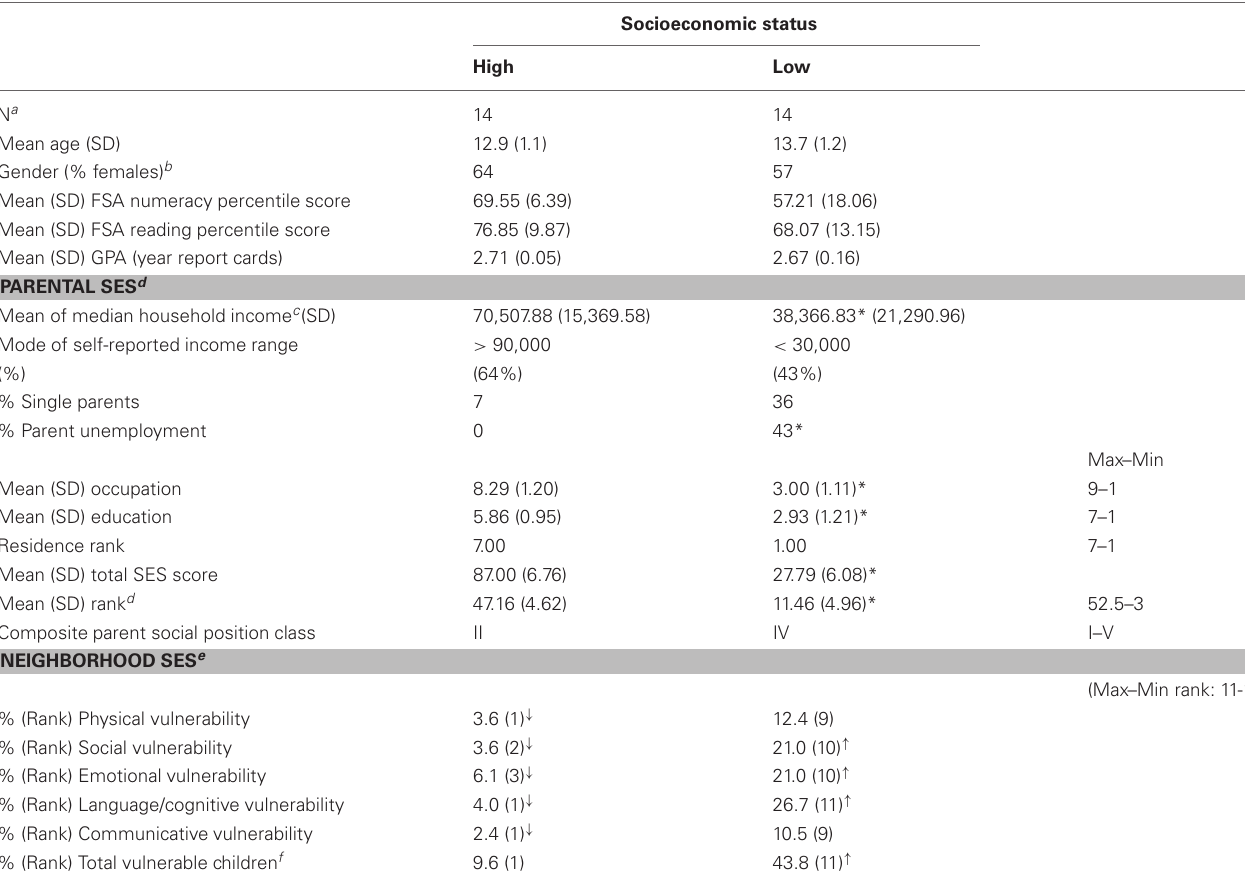
Table 1 | Family, neighborhood and demographic characteristics of the two groups of children